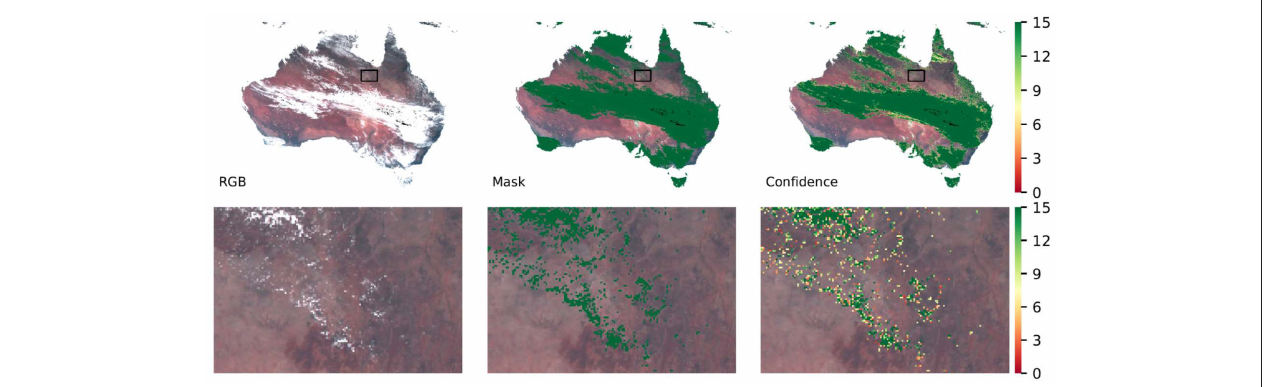
FIGURE 4 | Example of RGB composition, cloud mask and confidence for an AHI image acquired at 02:00 (UTC) on 2nd May 2016. The upper row shows continuous clouds across the Australian continent, and the lower row shows the details for a small region marked in the upper row with black rectangles. The left column shows the RGB image in which Red is AHI band 3 (0.64 µ m ); Green is band 2 (0.51 µ m ) and Blue is band 1 (0.47 µ m ). The central column shows the cloud mask (binary with cloud colored dark green), and the right column illustrates the cloud confidence (0–15) score. All the cloud mask and cloud confidence images are overlaid on the same RGB image as shown in the left